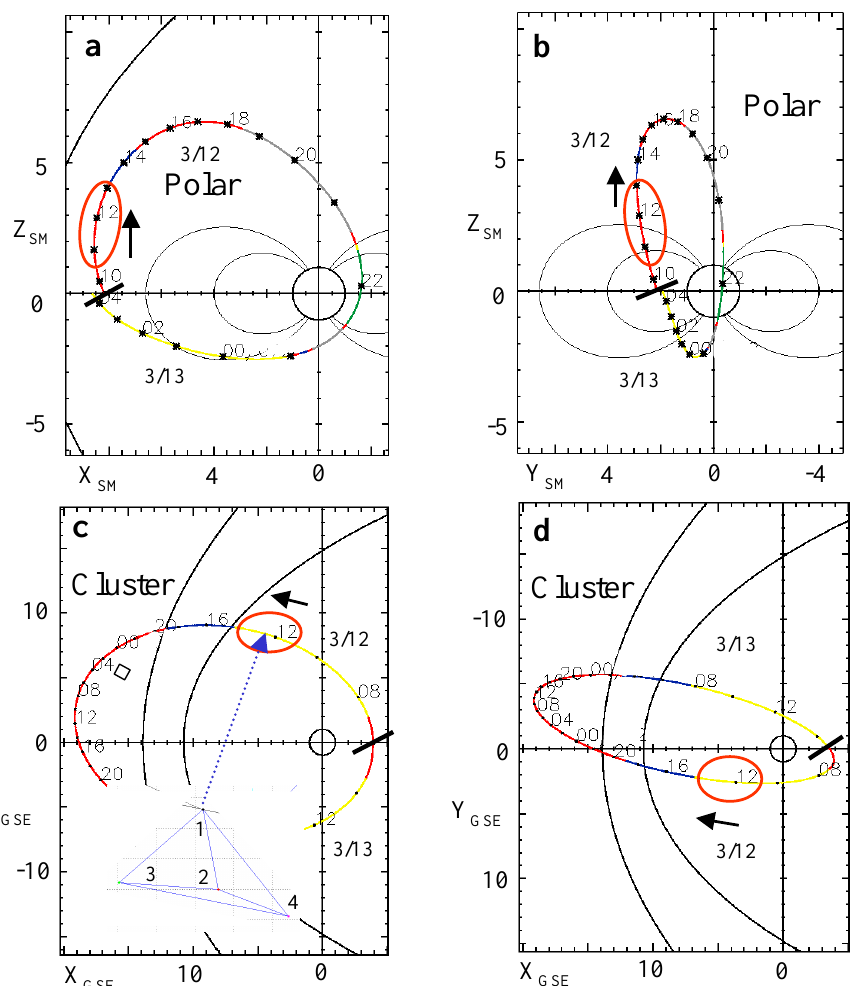
Fig. 1. Plots of the Polar orbit in the XZ and YZ solar magnetospheric (SM)coordinate planes and of the Cluster orbit in the XZ and XY geocentric solar ecliptic (GSE) planes for the 12 March 2001 event. The regions of interest are highlighted by the red ovals. The black line across the orbit track in each plot notes the start of the orbit trace. Nominal magnetopause and bow-shock configurations are indicted in panels a, c and d as appropriate. The circles at the origin represent the Earth. In panel c the insert shows the configuration of the 4 Cluster spacecraft, with Cluster 3 leading and Cluster 4 trailing. The tetrahedron configuration is maintained quite well during the interval of interest. Spacecraft separation is of the order of